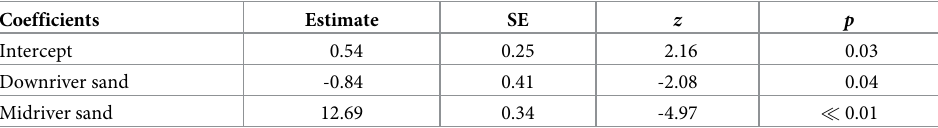
Table 5. Summary of GLM for model g 7 predicting percent cover, including parameter estimates (log-trans- formed), standard errors, z values and p values. The intercept represents downriver seagrass. Model g 7 explained 12.9% of the null